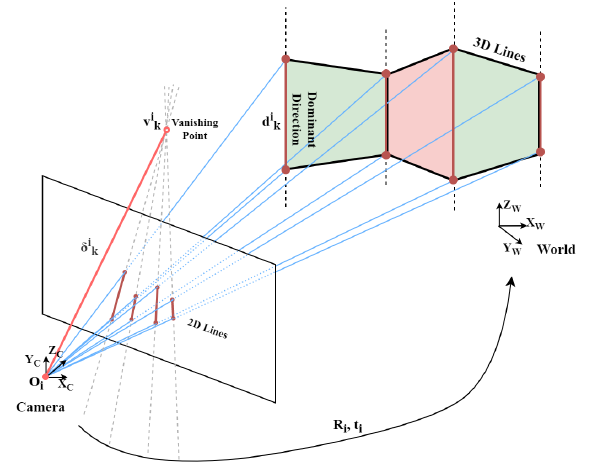
Figure 3. Geometric model of structure lines in Manhattan